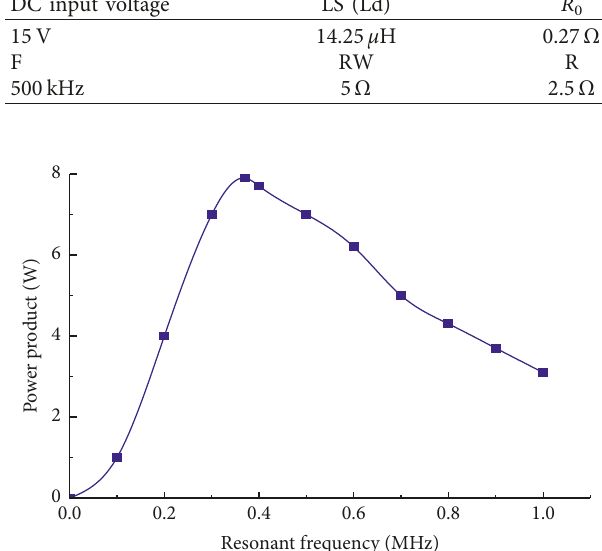
Figure 19: Relationship between the power product and resonant